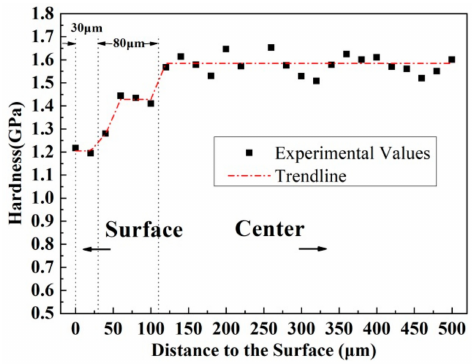
Figure 7. Micro-hardness values of di ff erent positions of original copper cylinder with a diameter of 1 mm.